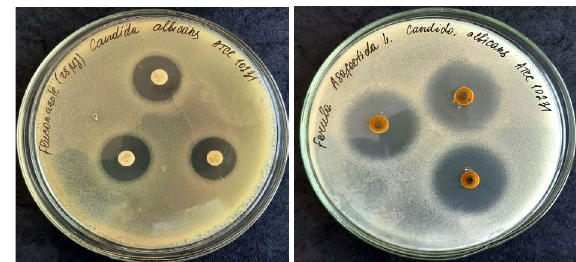
Fig. 4. Results of antimicrobial activity of CO of Ferula asafoetida L. and amoxicillin against Staphylococcus aureus ATCC 6538-P